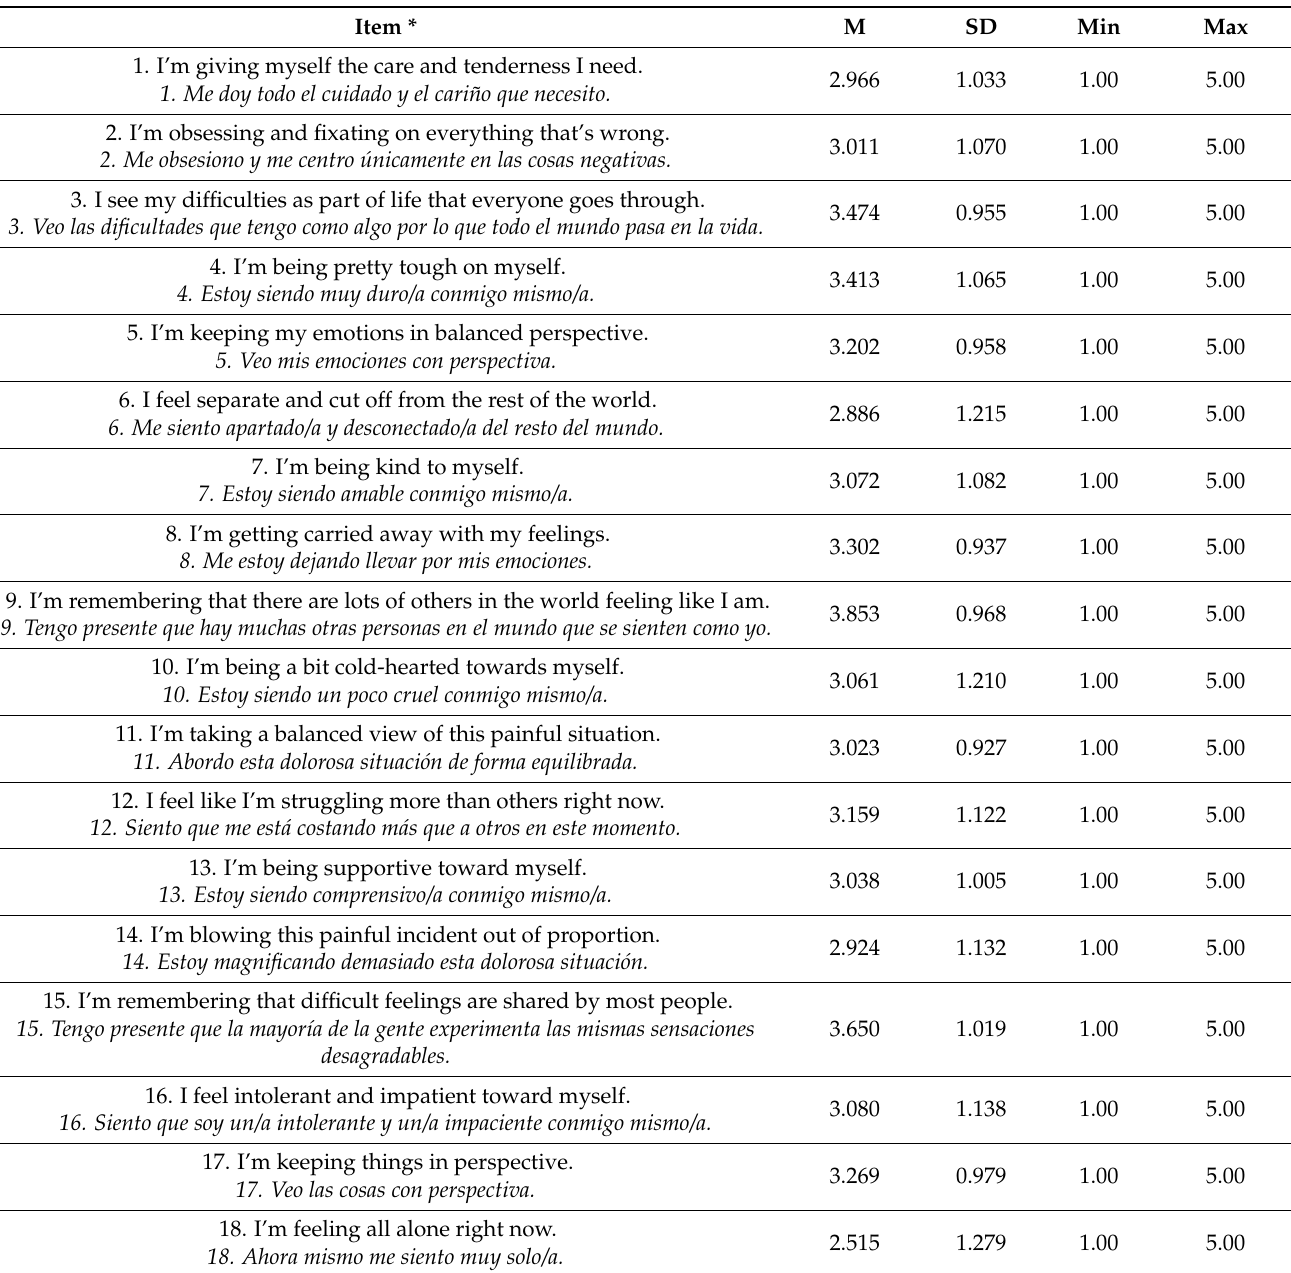
Table 1. Items and descriptive statistics for the